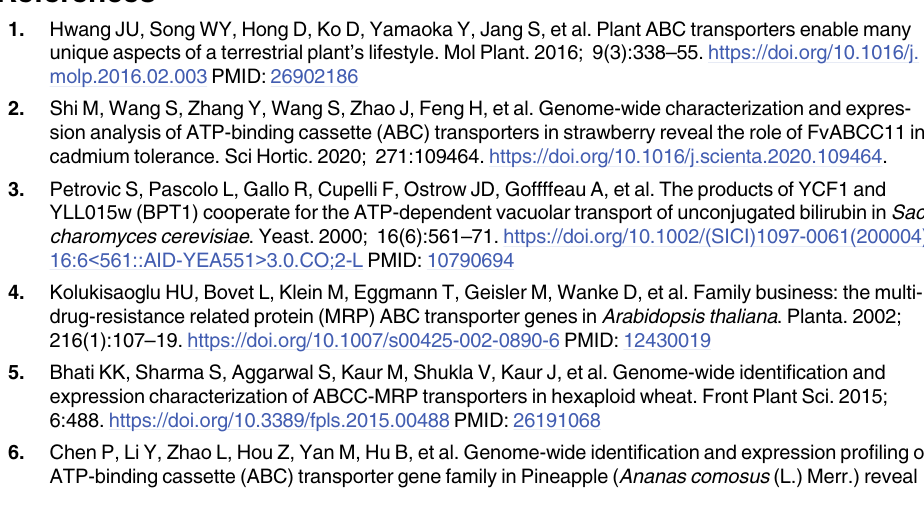
S9 Table. Relative transcript abundances of the RgABCCs in R . glutinosa roots of different development stages. S10 Table. Relative transcript abundances of the RgABCCs under various conditions. S11 Table. OD values of cell densities form the different genotype yeasts under CdCl 600 stress at various